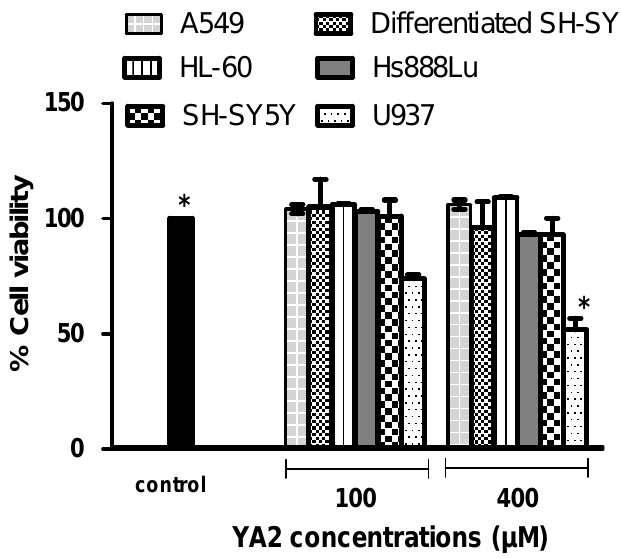
Figure 3. Cytotoxicity effects of YA2 in normal and tumour cell lines after 24 h incubation. Values are means ± SD (n = 3), all comparisons were made using two-tailed Student's t -test ( * p < 0.05, ** p < 0.01, *** p < 0.001).